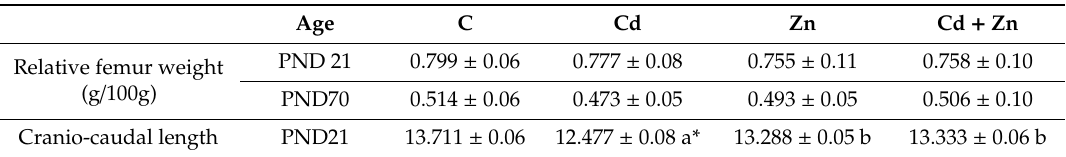
Table 2. Developmental parameters of male pups from mother rats treated with Cd and/or Zn during gestation and lactation periods.